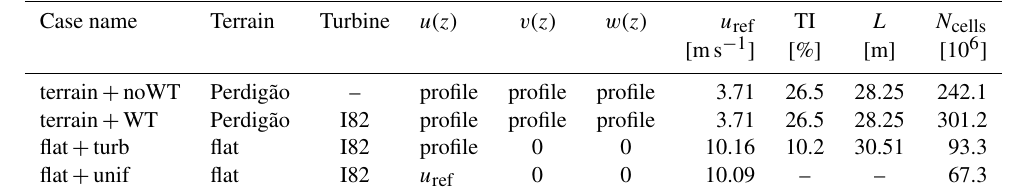
Table 2. Definition of FLOWer simulation cases with their inflow conditions and mesh size.